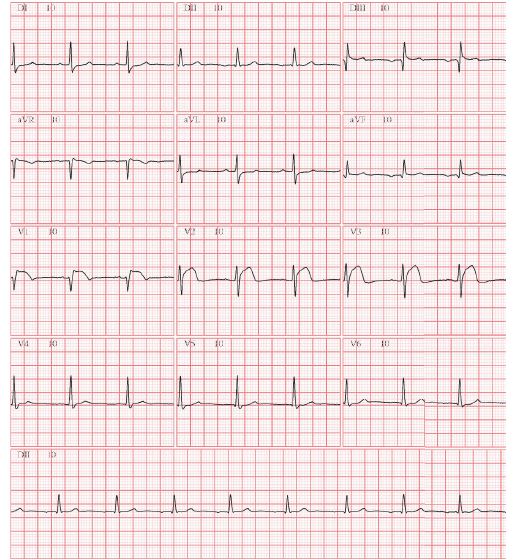
Figure 1: Admission electrocardiogram.